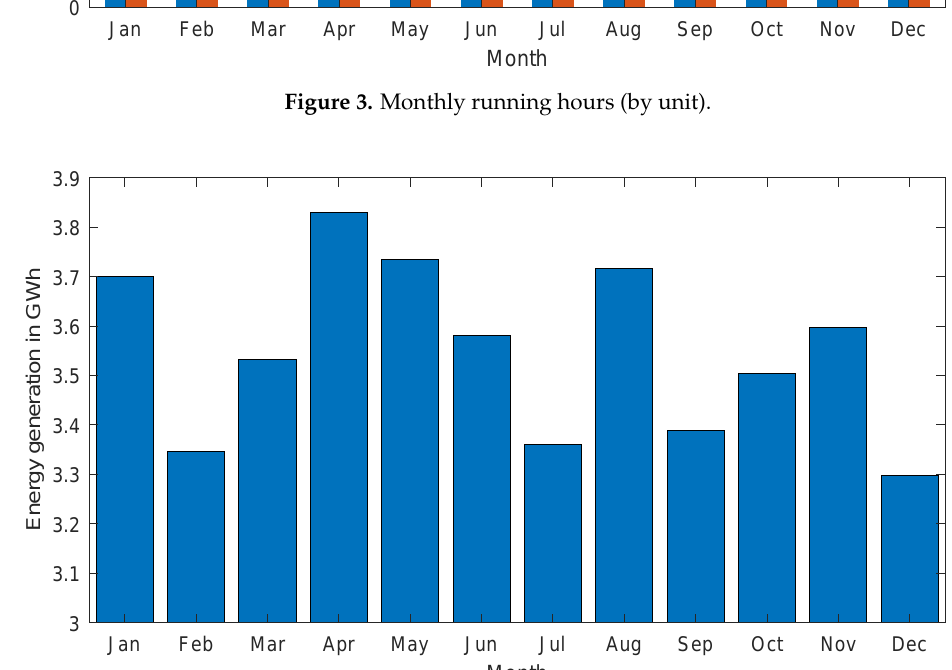
Figure 4. Monthly energy generation in